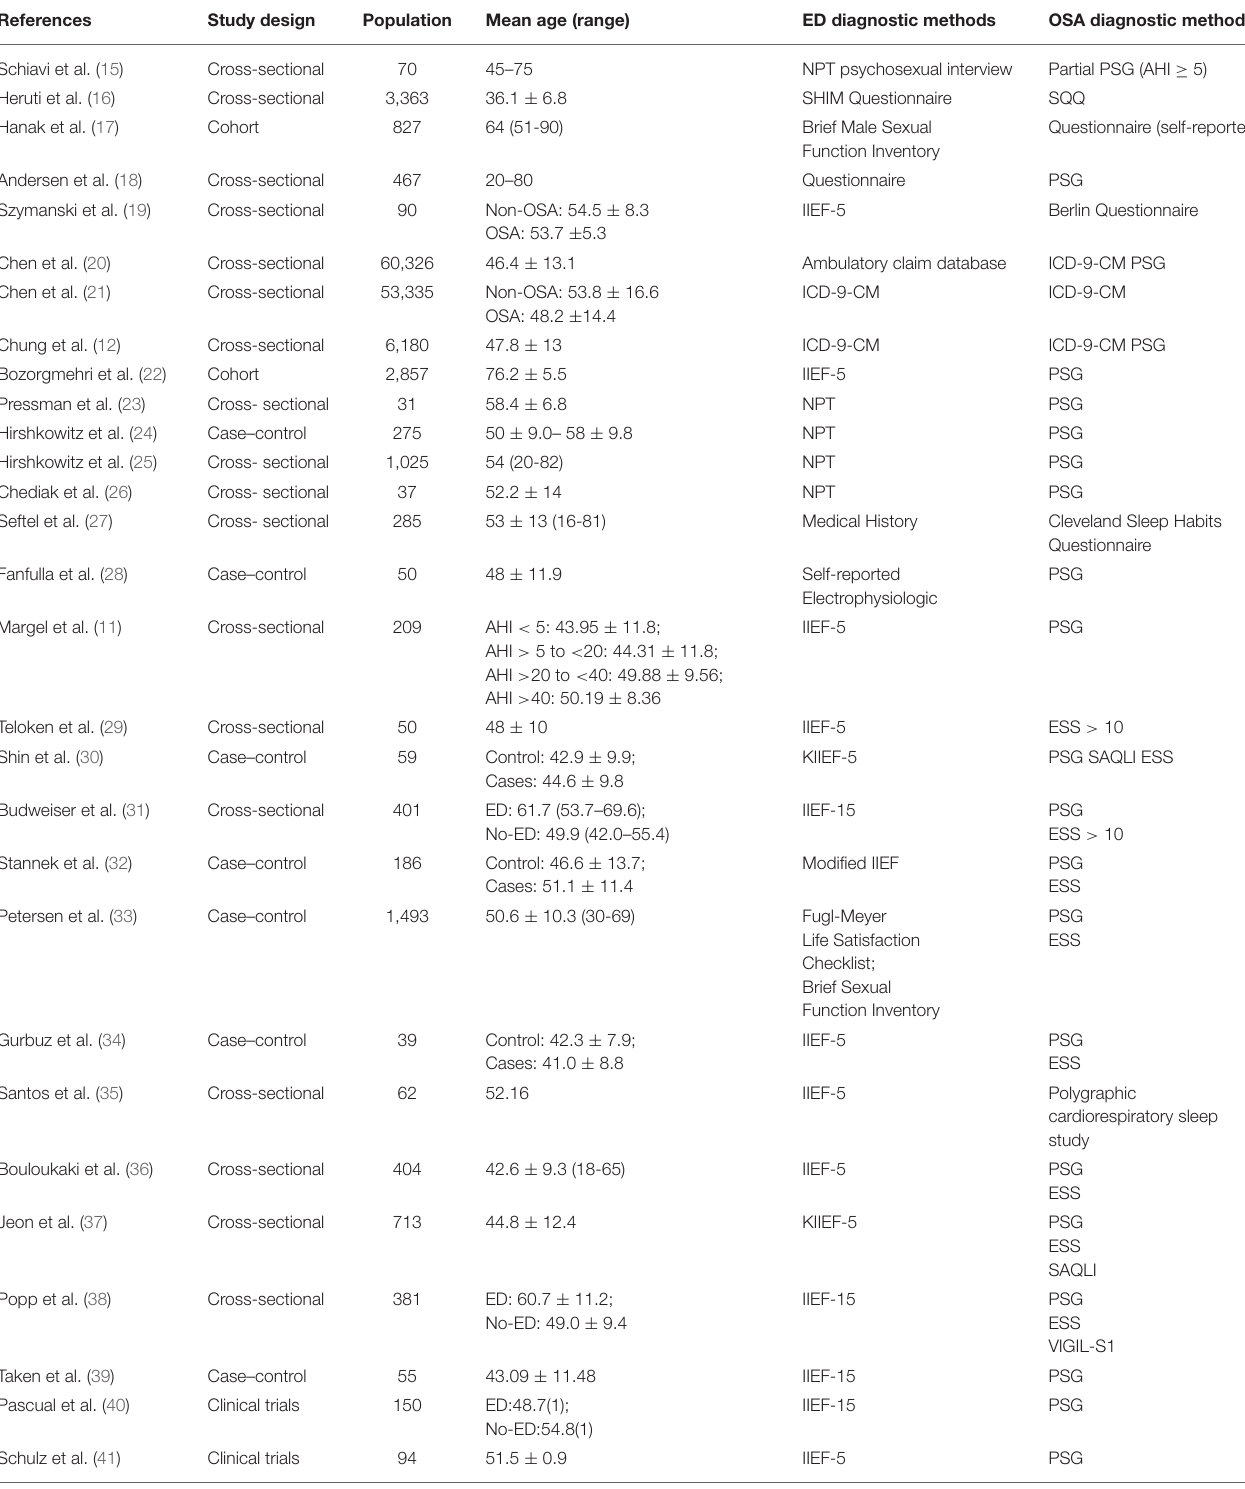
TABLE 1 | The characteristics of the included clinical